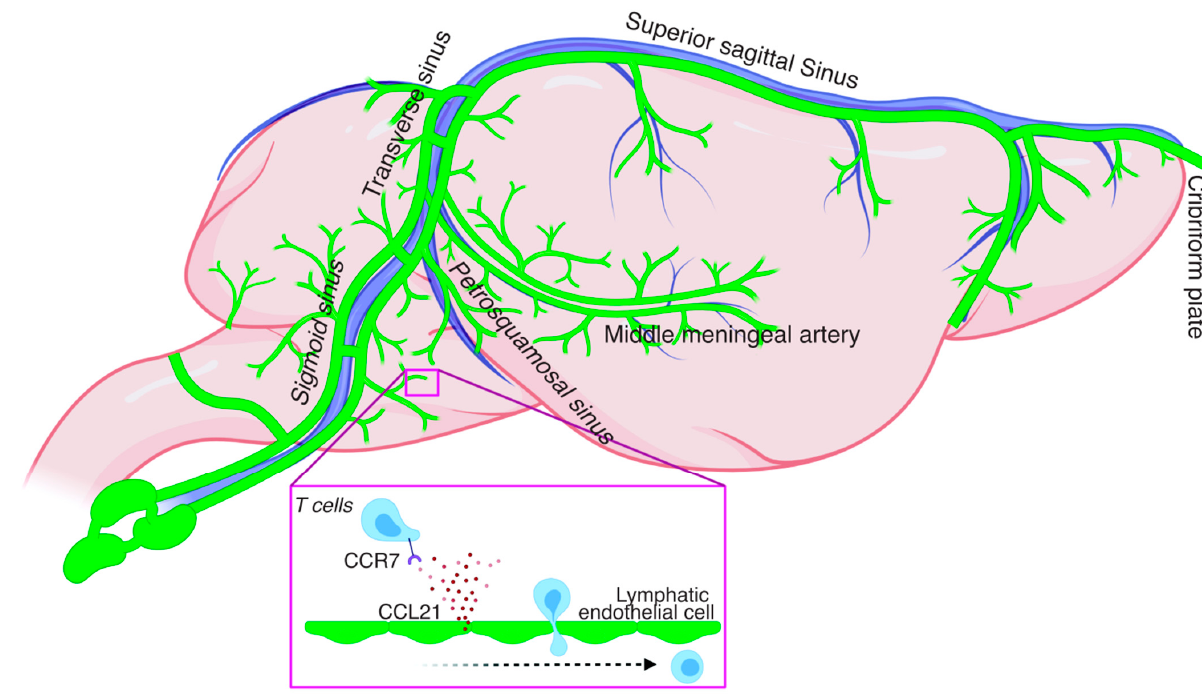
Figure 1. Scheme of rodent meningeal lymphatic network and CCR7-dependent T cell entry into the meningeal lymphatic vessel.